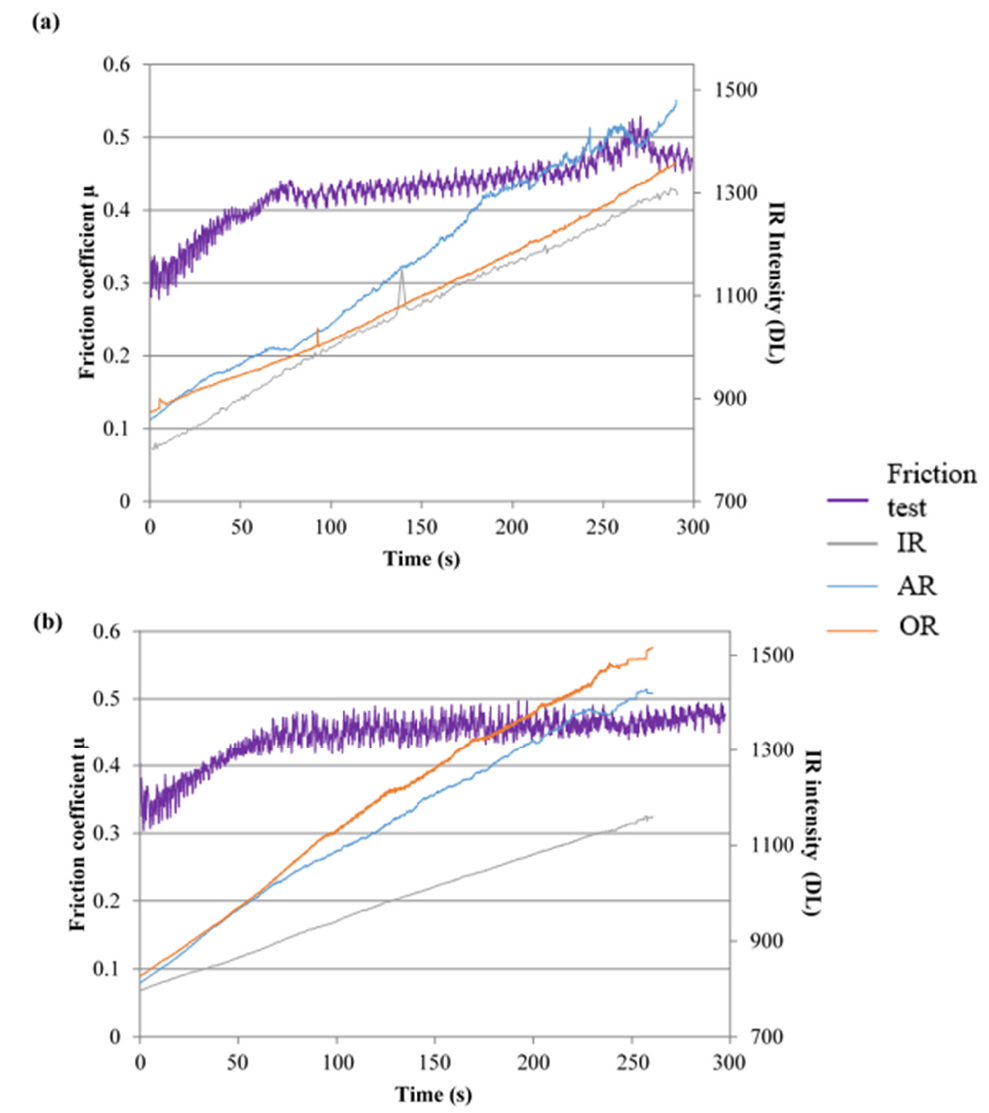
Figure 5. Friction coefficient evolution correlated with Infrared Radiation (IR) evolution over time for ( a ) FMFS and ( b ) FMFBs.